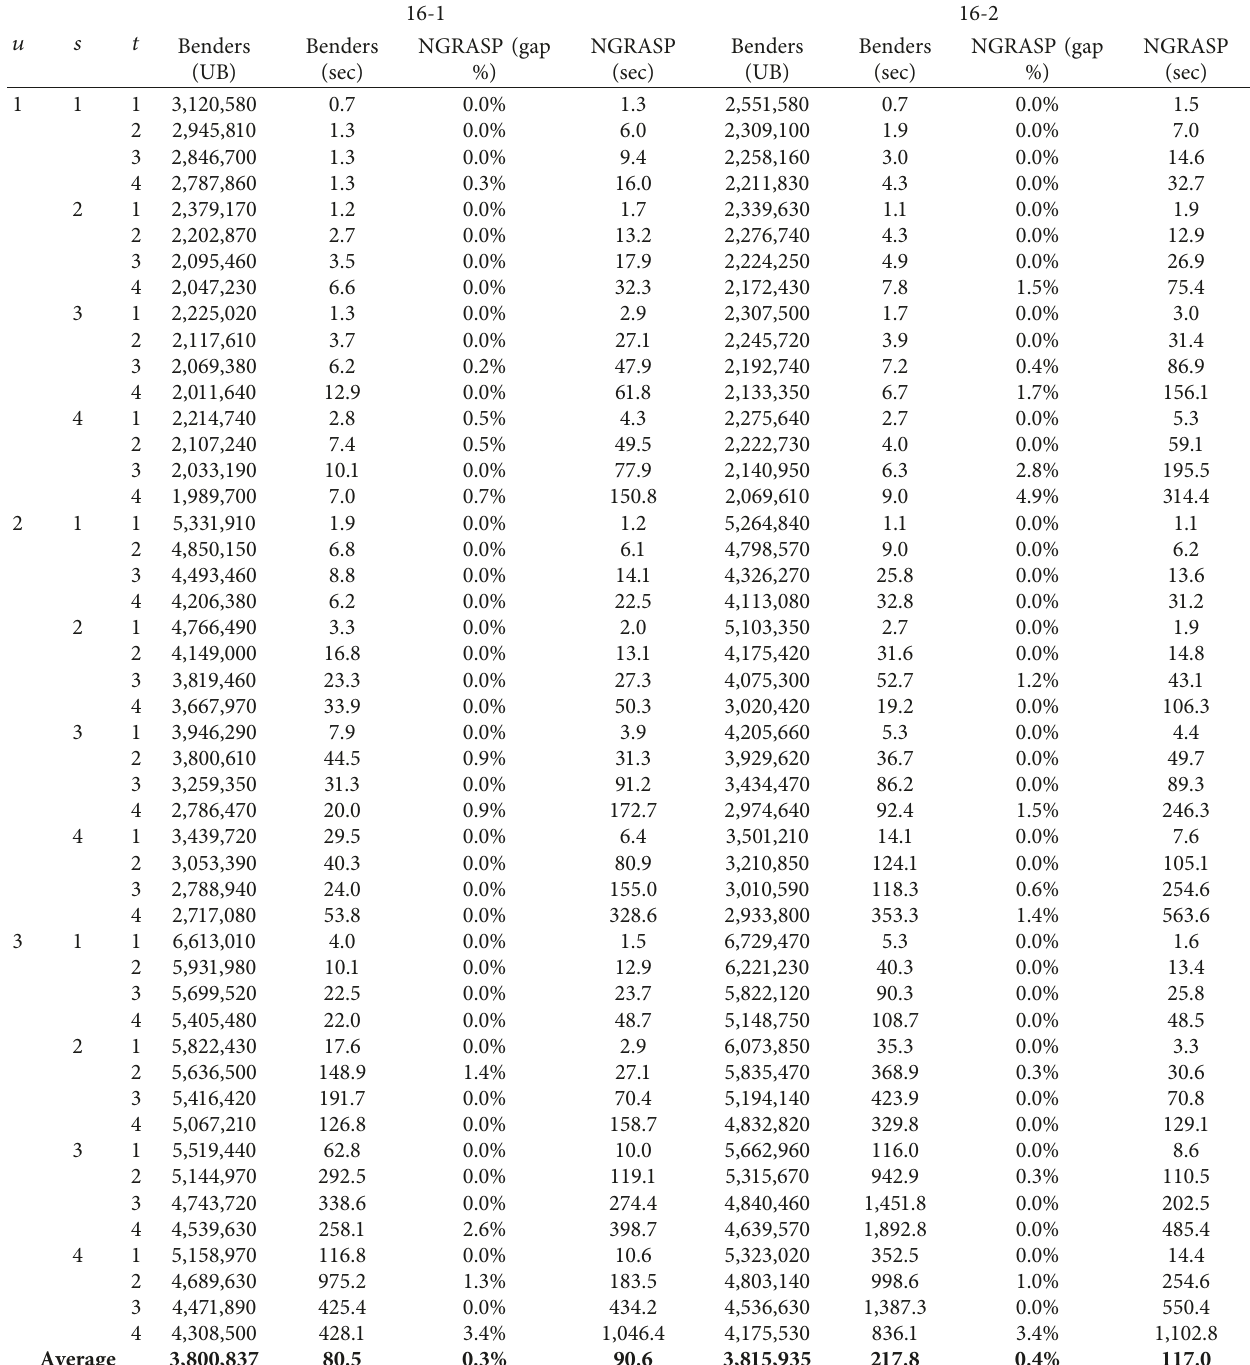
Table 6: Computational results on 16-node